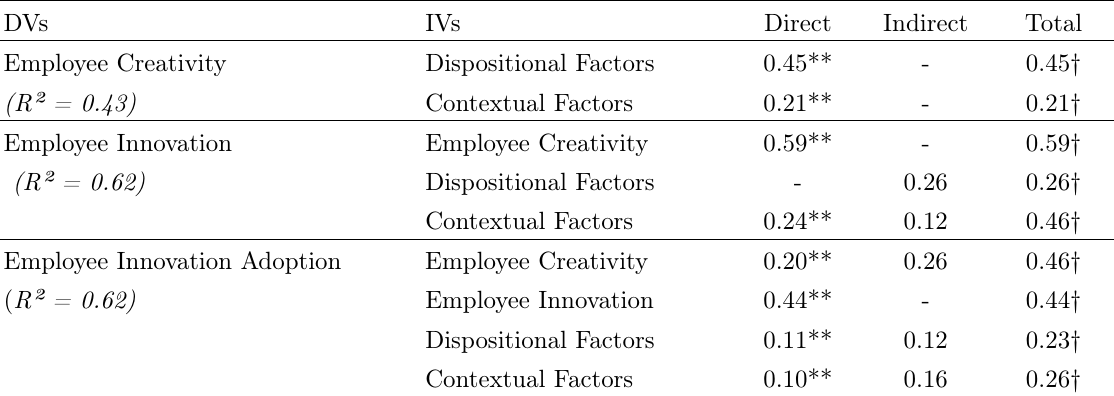
Table 9: Summary of the Causal Effects of the Exogenous on the Endogenous Factors in the Revised Model in Figure